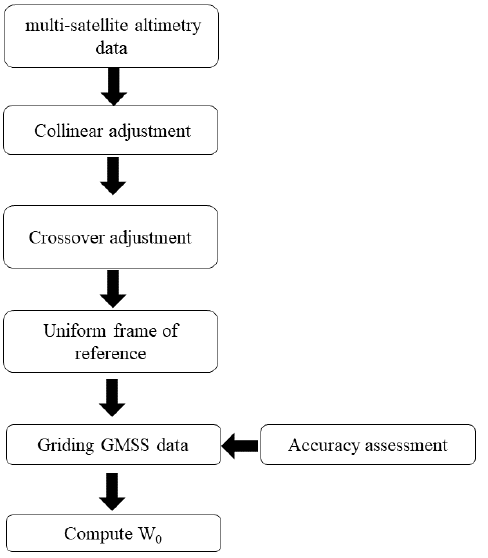
Figure 2. Process used to calculate the geoid potential constant W 0 by using altimetry data.